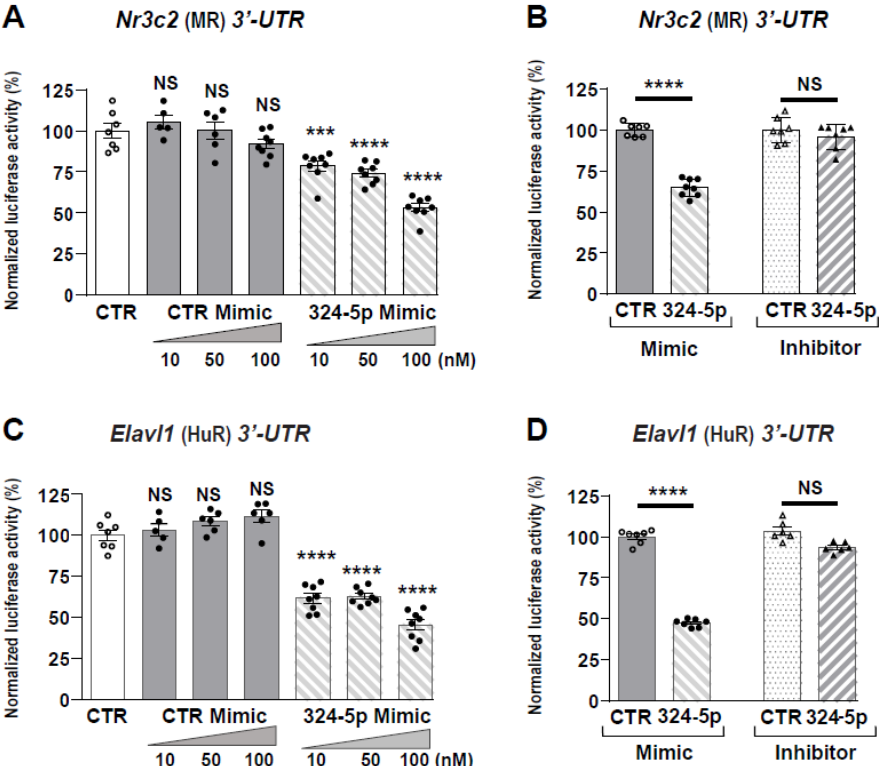
Figure 2. miR-324-5p functionally interacts with Nr3c2 (MR) and Elavl1 (HuR) 3′ -UTR. The murine Nr3c2 (MR) and Elavl1 (HuR) 3′ -UTR were cloned downstream of the pMIR-REPORT luciferase vector. ( A , C ) HEK 293T cells were transiently transfected, as described in Materials and Methods Section, with pMIR-luciferase plasmid (pMIR-Luc) fused to Nr3c2 (MR) or Elavl1 (HuR) 3′ -UTR (40 ng/well of 96-well plates) and incubated with increasing concentrations (10, 50, 100 nM) of negative control Mimics (CTR Mimic) or of 324-5p Mimics. Luciferase activities were measured 24 h after transfection and normalized to β -galactosidase activities. ( B , D ) HEK 293T cells were transiently transfected with pMIR-Luc fused to Nr3c2 (MR) or Elavl1 (HuR) 3′ -UTR (40 ng/well of 96-well plates) and 100 nM of CTR or 324-5p Mimics or with 100 nM of CTR or 324-5p Inhibitors. Luciferase activities were measured 24 h after transfection and normalized to β -galactosidase activities. Data are means ± SEMs ( n = 8). NS = not significant, *** p < 0.001, **** p < 0.0001 compared to luciferase activity of pMIR-Luc fused to Nr3c2 (MR) or Elavl1 (HuR) 3′ -UTR without Mimics ( A , C ) or with CTR Mimic or CTR inhibitor ( B , D ), arbitrarily set at 100%.